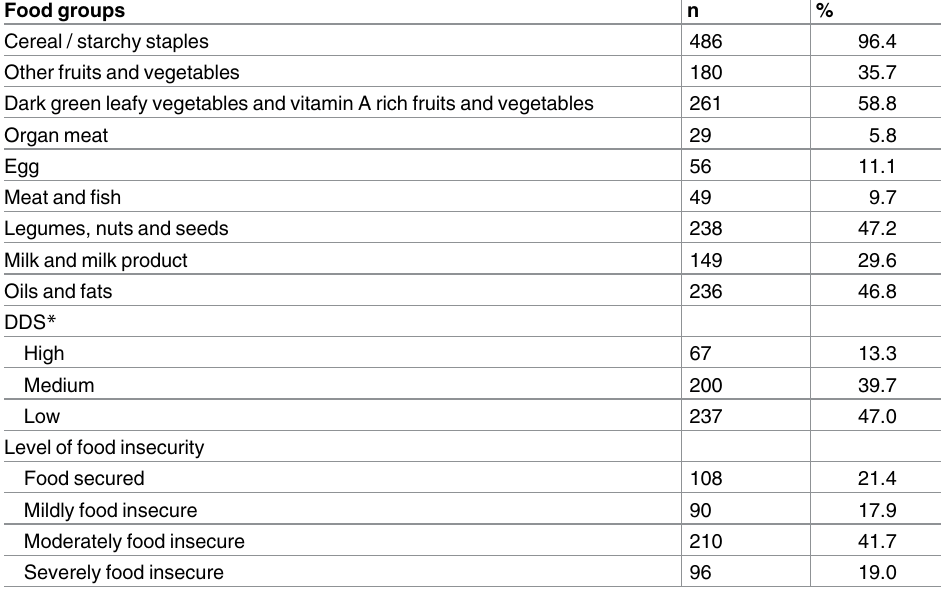
Key : DDS * = Dietary diversity score